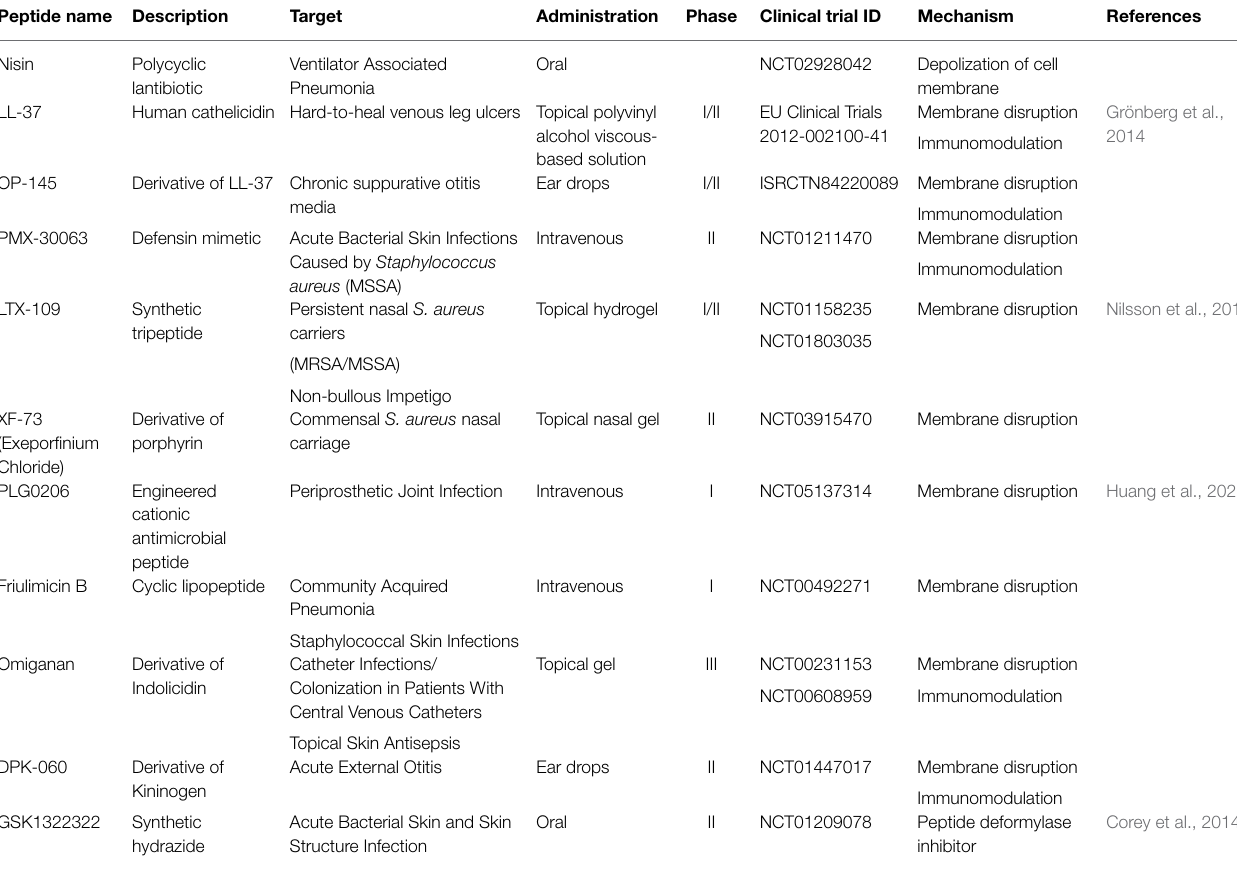
TABLE 2 | Some antimicrobial peptides (AMPs) under investigation and clinical phase of development for treatment of Staphylococcal